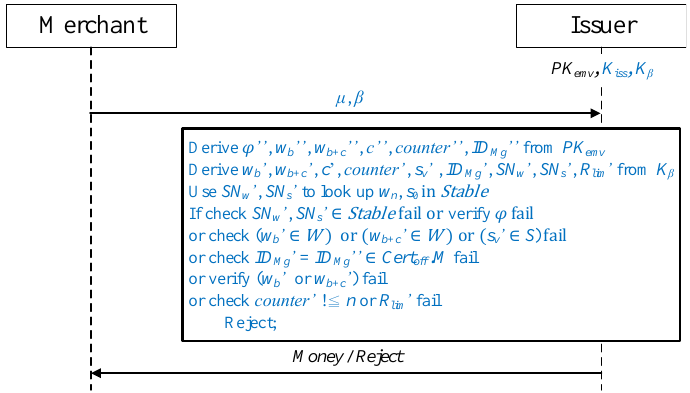
Figure 9. Merchant payment request